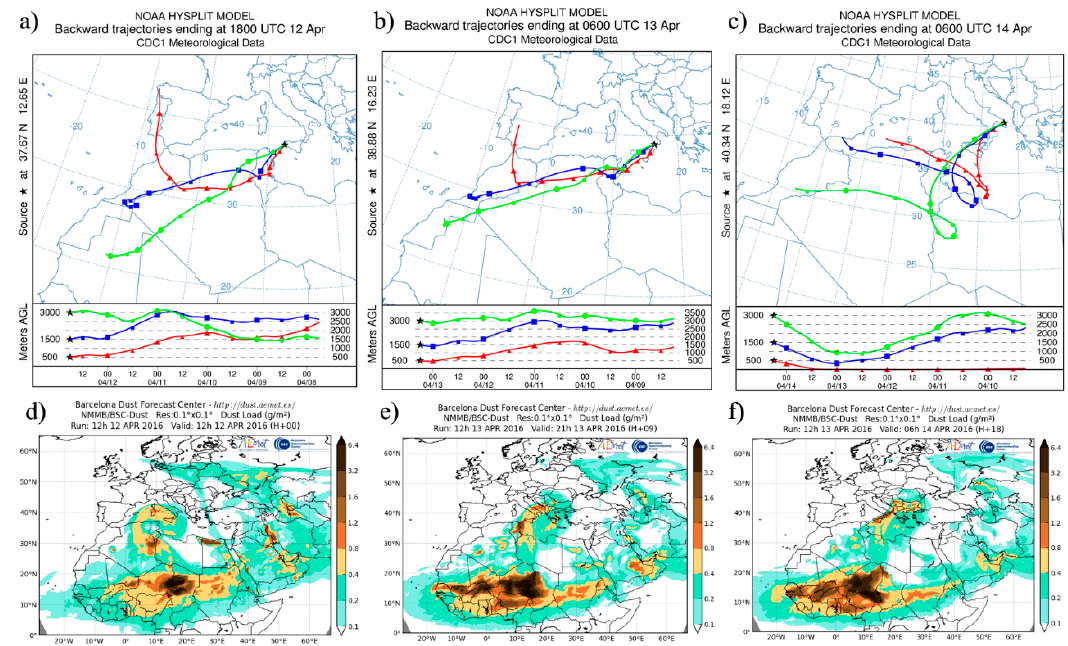
Figure 5. HYSPLIT model results of the Sahara dust event for ( a ) CGR, ( b ) LMT, and ( c ) ECO stations, respectively. Aerosol dust load map on the Mediterranean area for ( d ) 12th, ( e ) 13th and ( f ) 14th April.